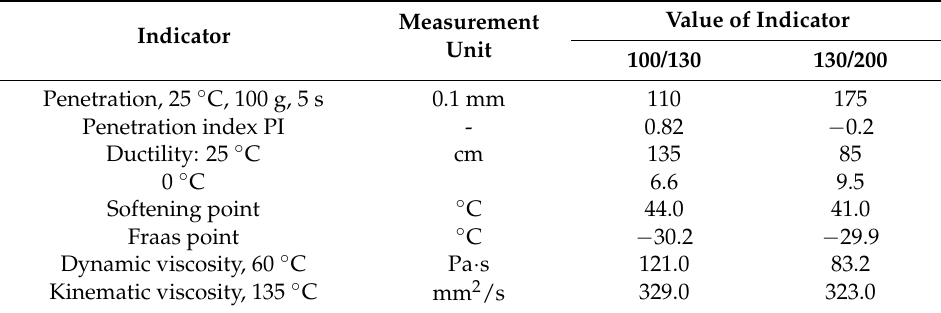
Table 1. Main standard indicators of neat bitumens.